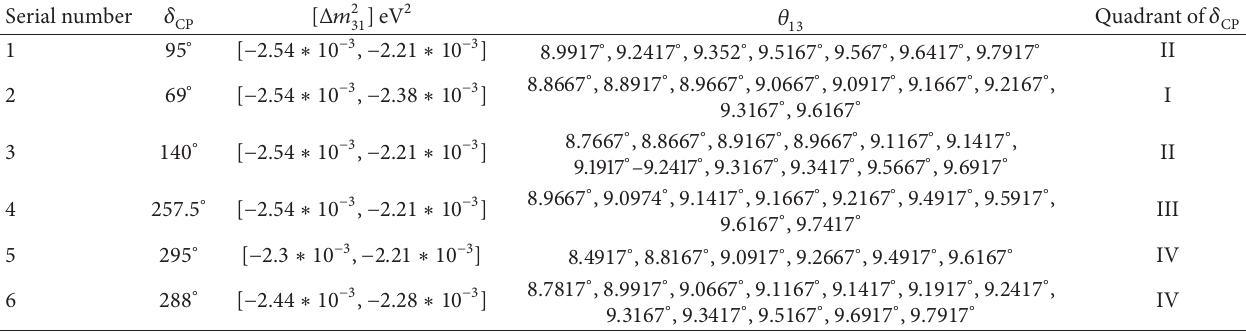
Table 2: The summary of our calculated values of 𝛿 CP , 𝜃 13 , and Δ𝑚 2 31 in case of IH and HO for 𝑅 1𝑗 elements of 𝑅 matrix comprising 𝑈 PMNS and 𝑉 CKM